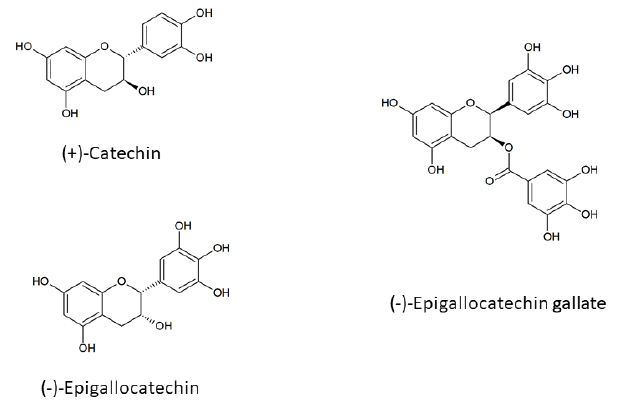
Figure 1. Structures of monomeric flavanols used in this study.